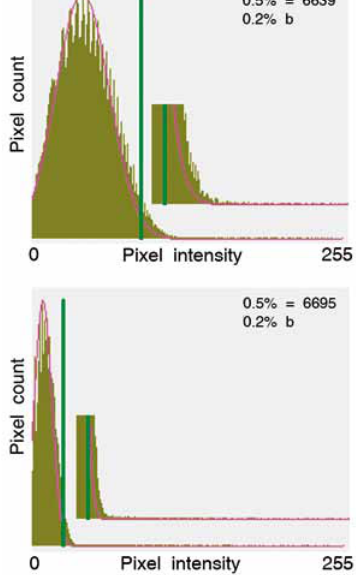
Fig. 1. Frame pixel intensity distribution examples with different background intensity Notes: Background threshold level selected to leave 0.2% of background distribution pixels. In both cases that means ~0.5%